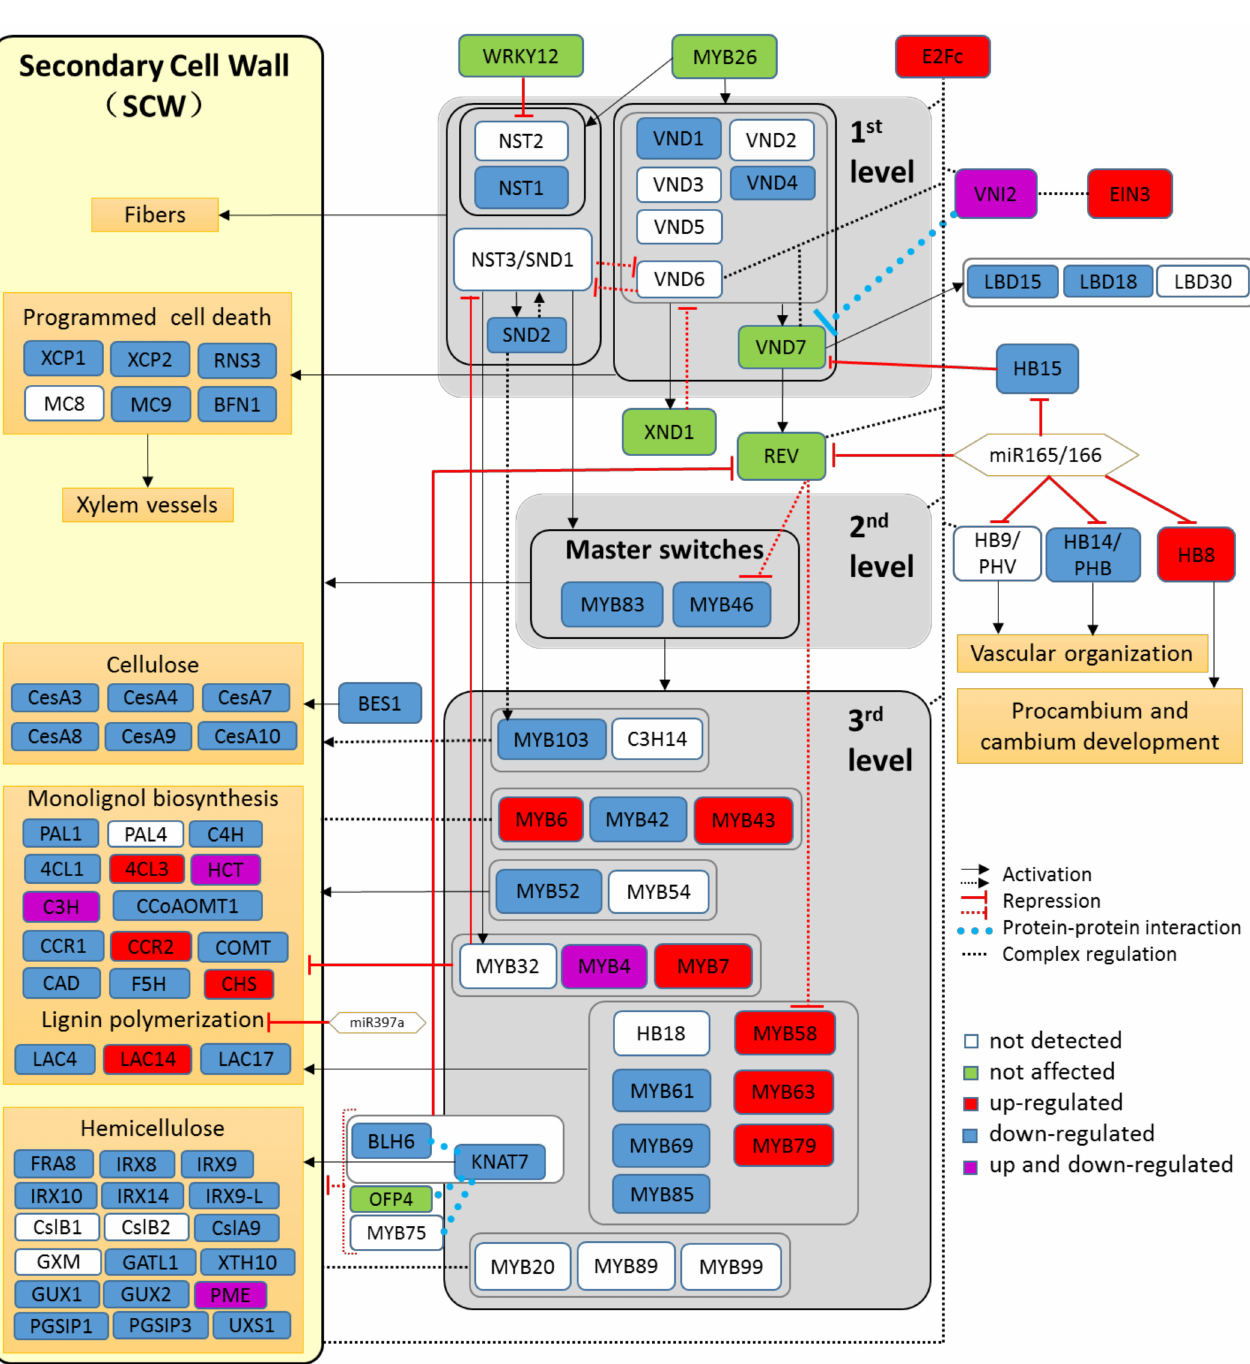
Figure 6. Transcriptional regulation of genes for secondary cell wall formation in poplar (hybrid T89) wood in response to severe drought stress. The cell wall signaling cascade was modified after Zhang et al. [19] and Hussey et al. [71] and shows the poplar homologs to Arabidopsis genes. Color code: White: genes not detected. Green: genes not significantly affected. Red: genes significantly up-regulated. Darkblue: genes significantly down-regulated. Magenta: poplar homologs show contrasting responses. Please note that poplar often contains several homologs that match one Arabidopsis thaliana locus. The data are shown Supplemental Table